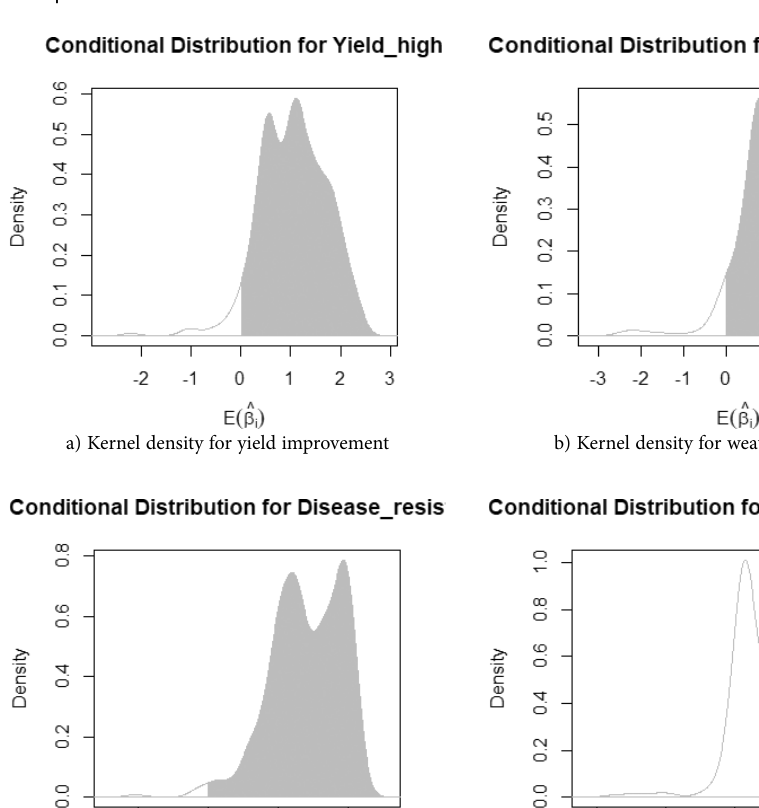
Figure A-1. Distribution of the individuals’ conditional mean for the parameters of yield, weather tol- erant, diseases resistant and maturity duration. The grey area displays the proportion of individual with positive conditional